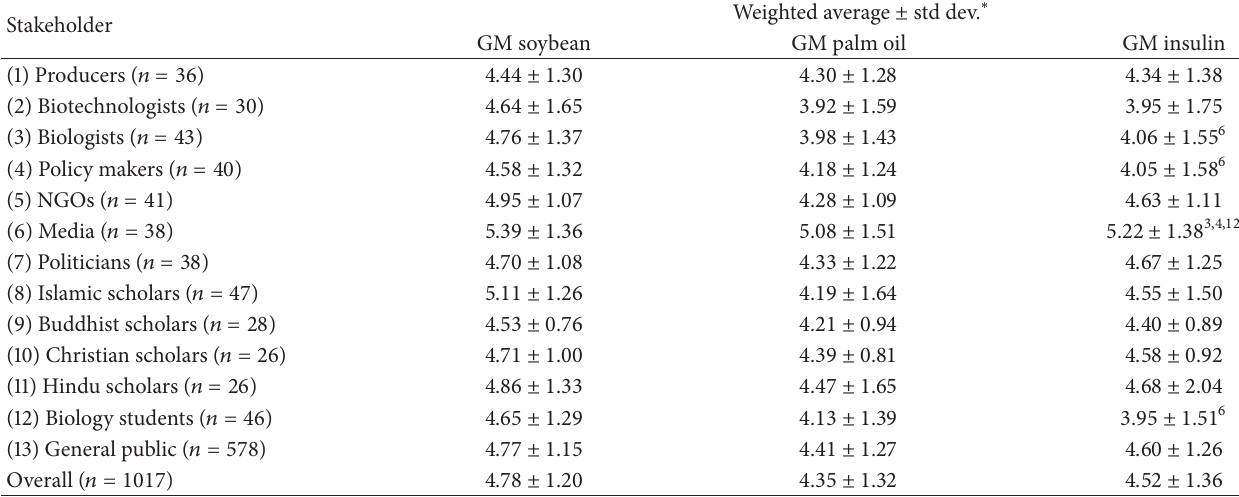
Table 6: Weighted average and post hoc test results for perceived risks of GM foods and GM insulin.